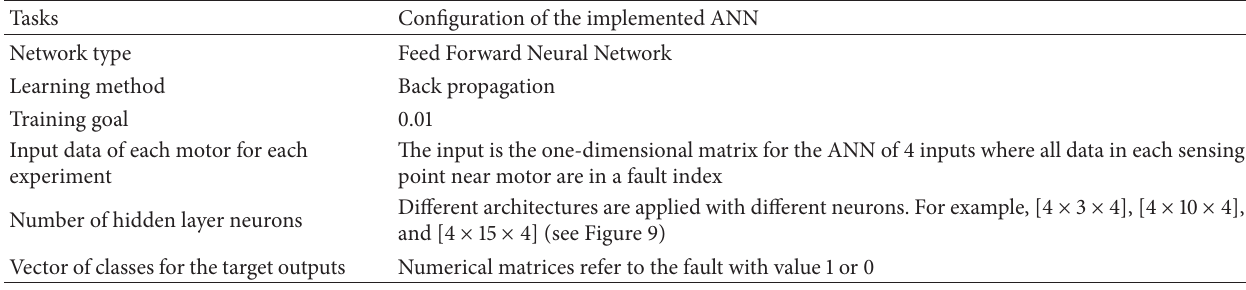
Table 4: Description of the implemented ANN.